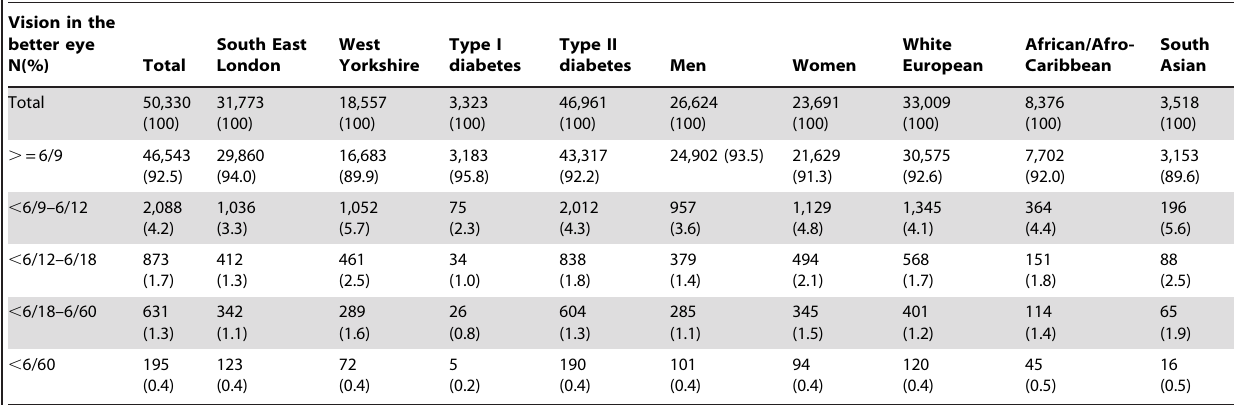
Table 3. Distribution of visual acuity by various demographic factors.